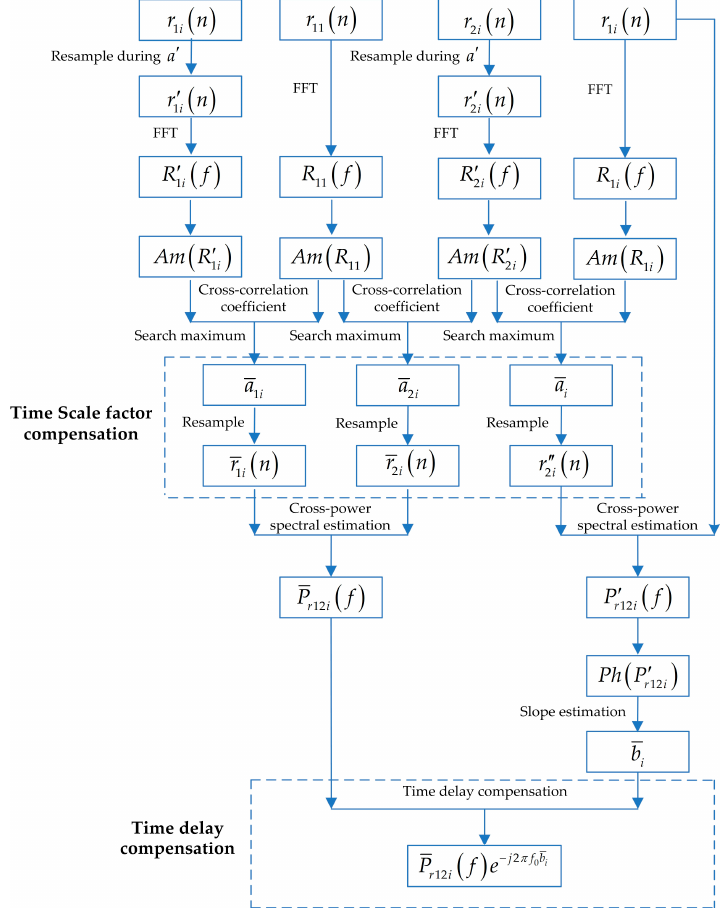
Figure 2. The flow chart for time scale factor and time delay compensations of cross ‐ power spectrum.